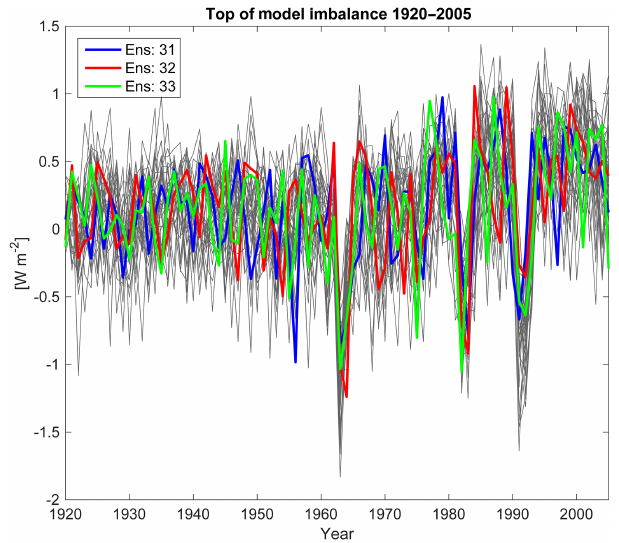
Figure 4. Top-of-model energy imbalance from 1920 to 2005. CESM-LE members 2–30 are indicted in gray and the three new members (31–33) are designated in the legend. Note that mem- bers 31 and 33 have been subjected to lossy compression.